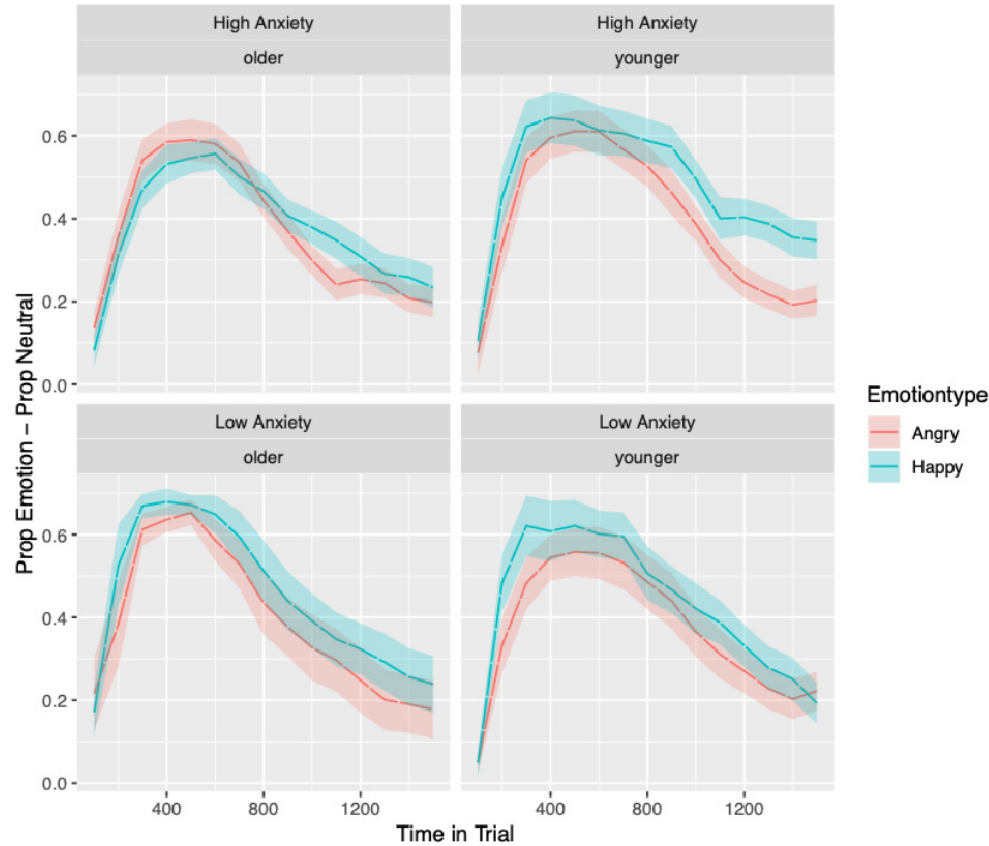
Figure 5. Time course of bias to looking at the emotional face as the first face viewed averaged over trials, split by emotion type, age and anxiety grouping. Standard errors in the proportion of looking to AOIs can be seen as shaded areas surrounding the lines denoting anxiety groups.